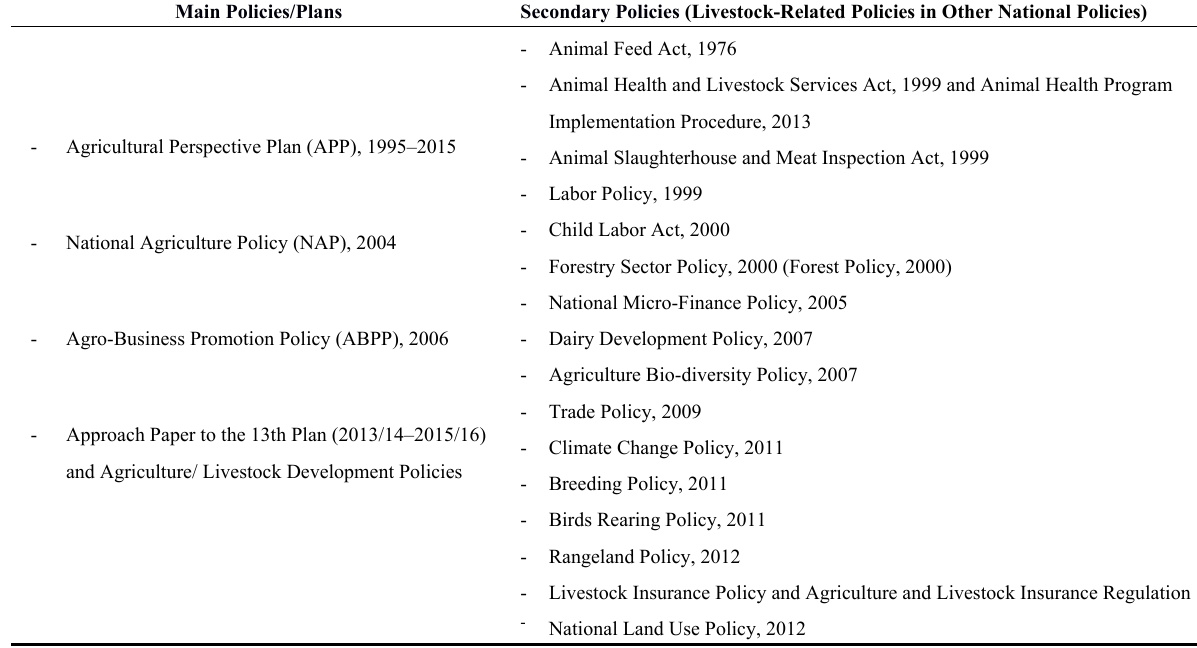
Table 1. List of main and secondary national livestock policies/plans 1 reviewed. Main